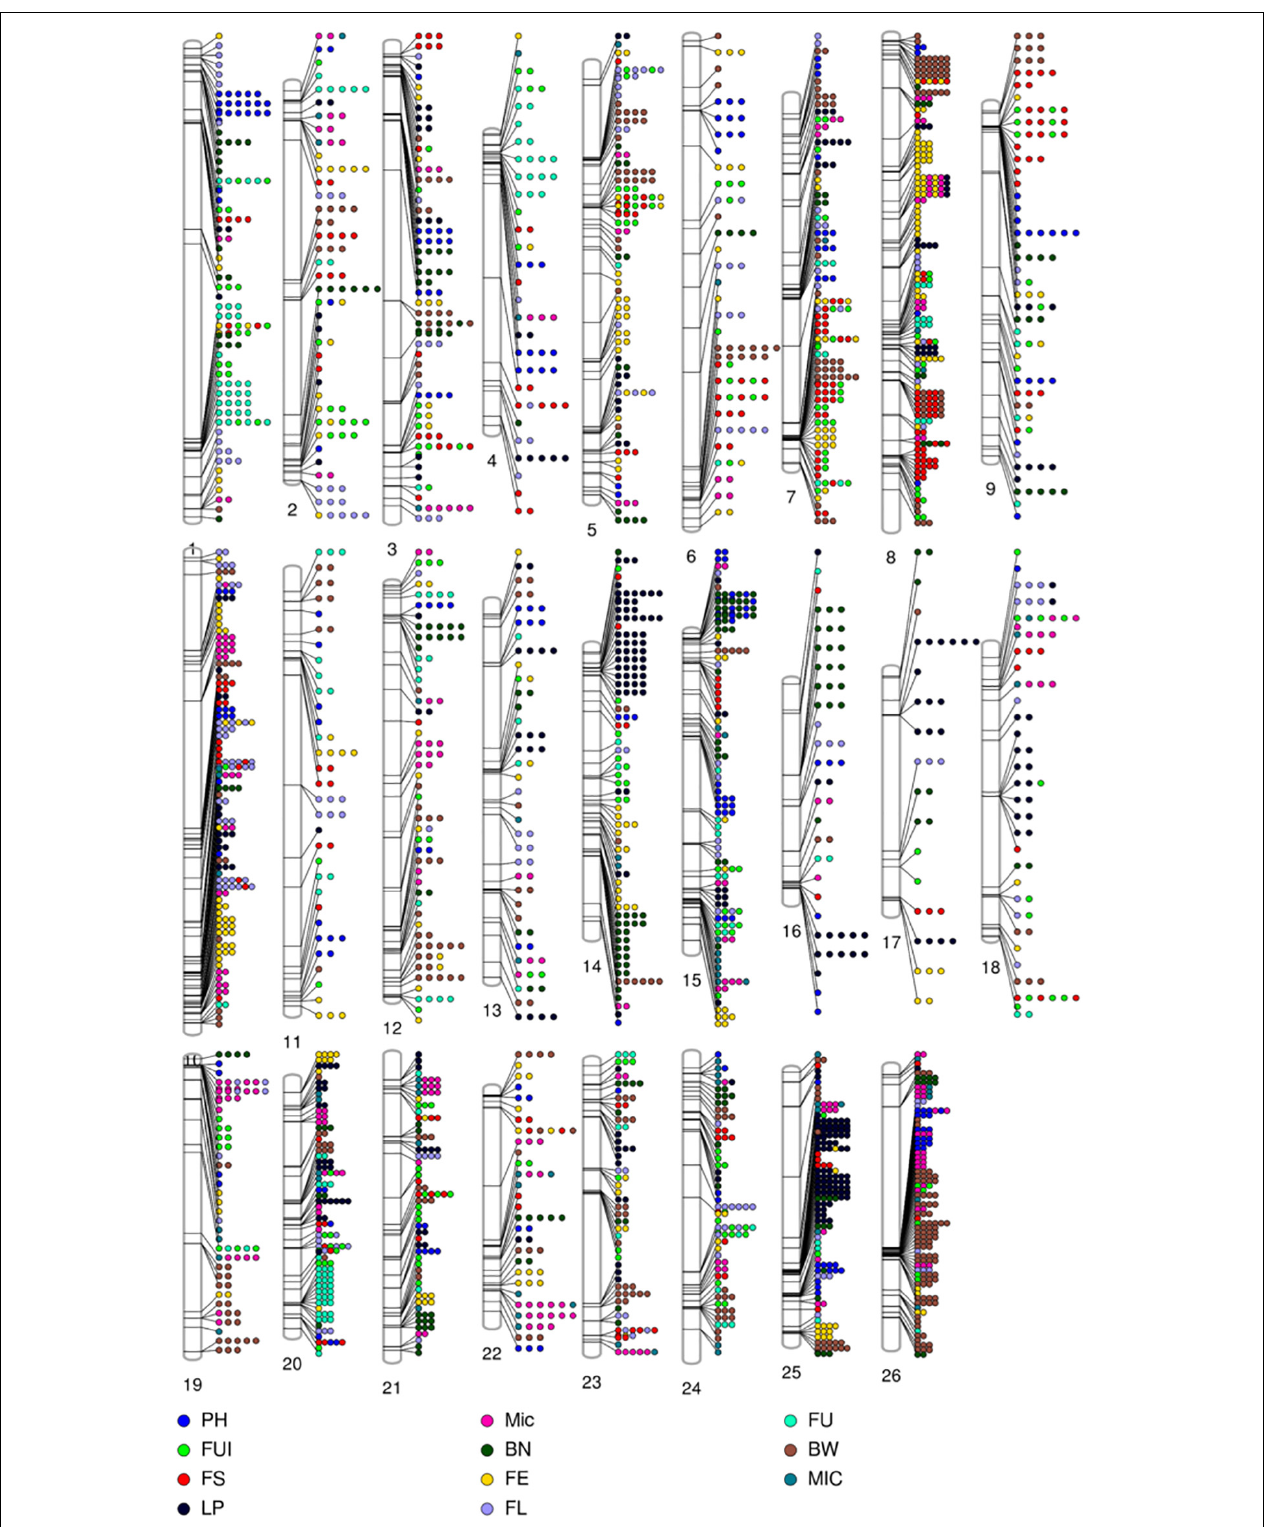
FIGURE 5 | Phenogram displaying the 2847 significant ( – log ( p ) ≥ 4) associations among phenotypic traits and 1348 significant SNPs residing on 26 chromosomes of upland cotton.